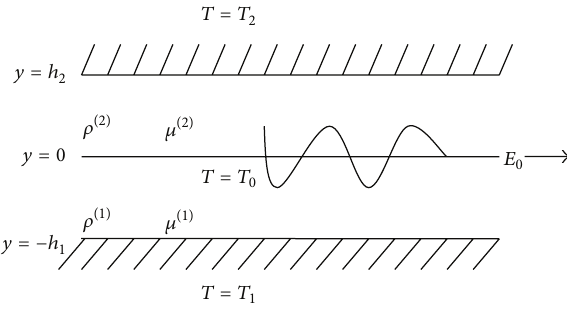
Figure 1: The equilibrium configuration of the